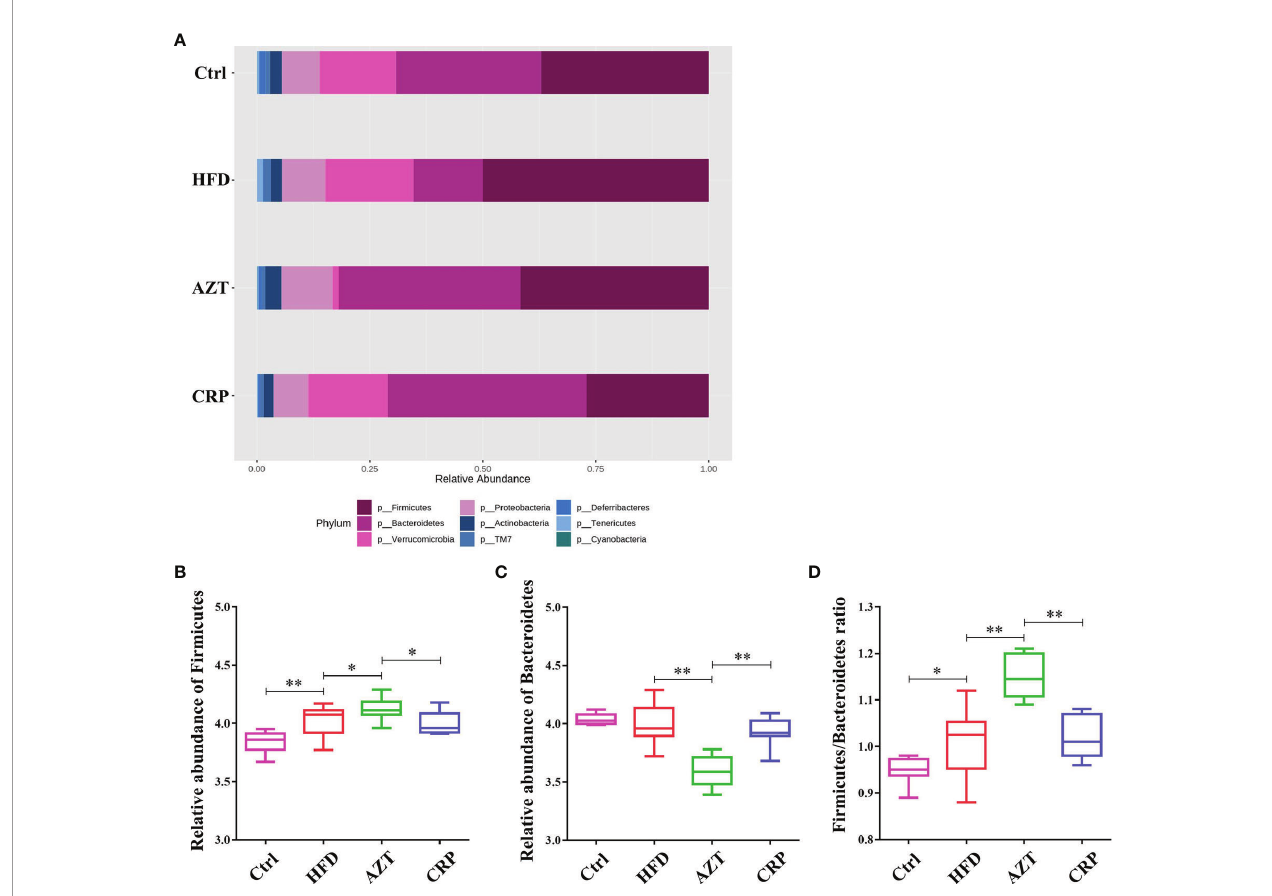
FIGURE 8 | Changes in microbes at the phylum level in faeces between the groups. (A) Changes in the relative abundance of microbes at the phylum level. (B) Relative abundance of Firmicutes. (C) Relative abundance of Bacteroidetes. (D) Firmicutes/Bacteroidetes ratio. Differences were assessed by ANOVA. Data are expressed as the mean ± SEM, n = 9 for the CRP group and n = 10 for the other groups. *P < 0.05, **P <